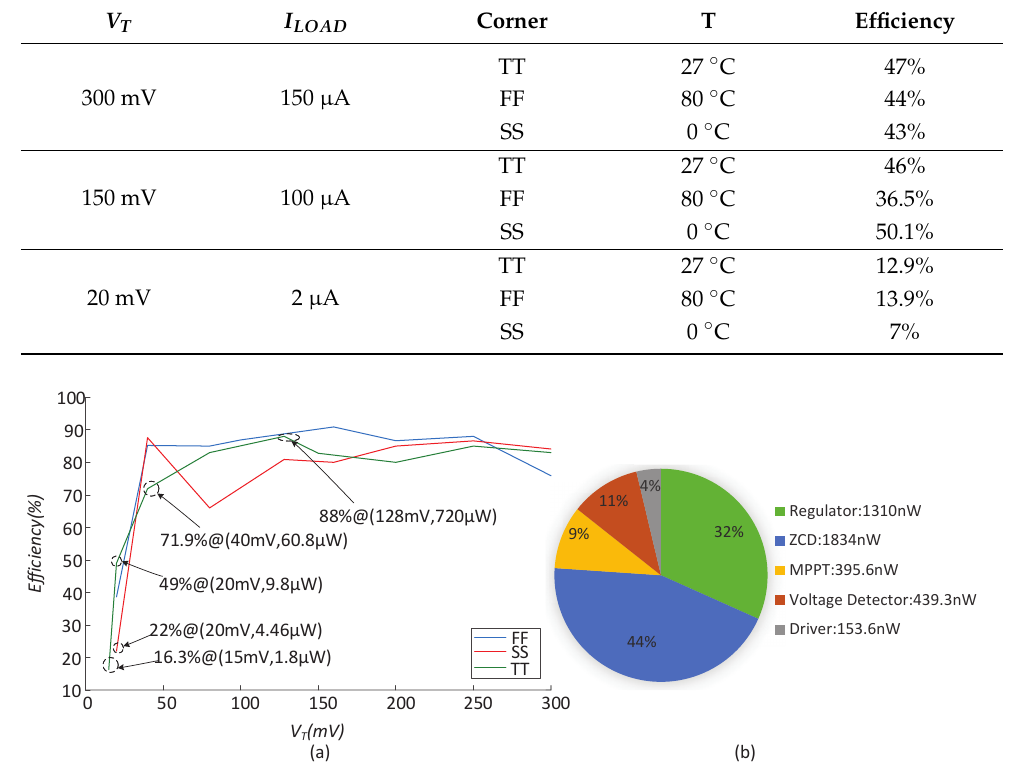
Table 3. Conversion efficiency versus light load current under different corners and temperatures.